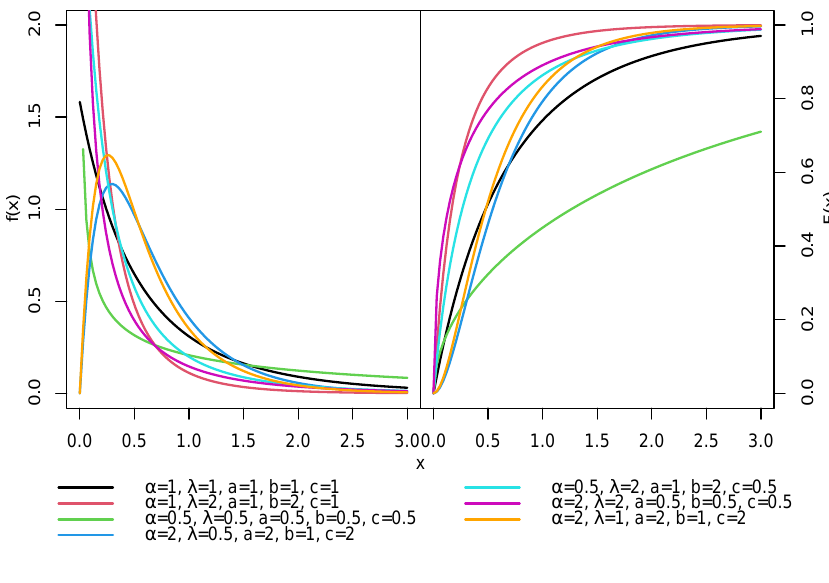
Figure 1 – PDF (left panel) and CDF (right panel) of McExP